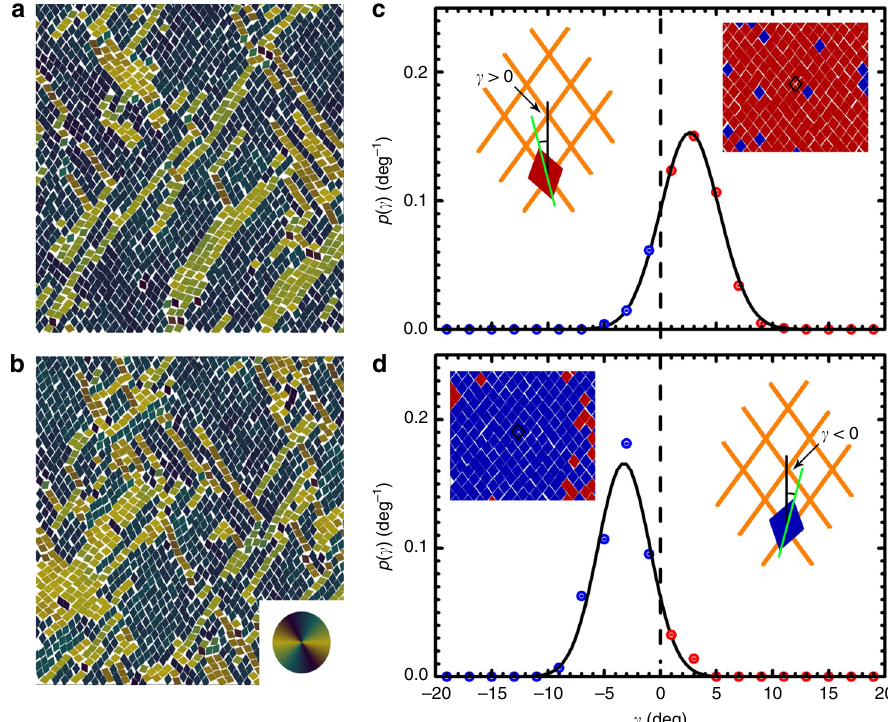
Fig. 7 Twinning structures and the emergence of chirality in RB crystals. a Polysynthetic twin and b cyclic twin structures formed by kites of α = 72° at ϕ = 0.798 and 0.787, respectively, obtained by MC simulations (NPT ensemble). Particles are colored based on their orientations. Color wheel: encodes A particle orientations with twofold symmetry. c , d Evidence of chiral symmetry breaking in RB crystals: tilting of rhombs in kites of α = 72° at ϕ A = 0.906, obtained by MC simulations (NPT ensemble). Probability distribution, P ( γ ) (in deg − 1 ), where γ is the angle difference between the orientation of a rhombus and one diagonal direction of the RB crystal lattice. If the orientation of the rhombus deviates clockwise from the diagonal lattice direction, then γ is negative (blue points and rhombs); otherwise, γ is positive (red points and rhombs). Black solid lines: least-squares fi ts to Gaussian functions. c Example of positive-deviation RB crystal. Left inset: schematic showing γ > 0 for a single rhomb. Right inset: color-coded micrograph that has γ ave > 0; the black rhombic outline in the micrograph shows a unit cell of the RB lattice. d Example of negative-deviation RB crystal. Left inset: color-coded micrograph that has γ ave < 0; the black rhombic outline in the micrograph shows a unit cell of the RB lattice. Right inset: schematic showing